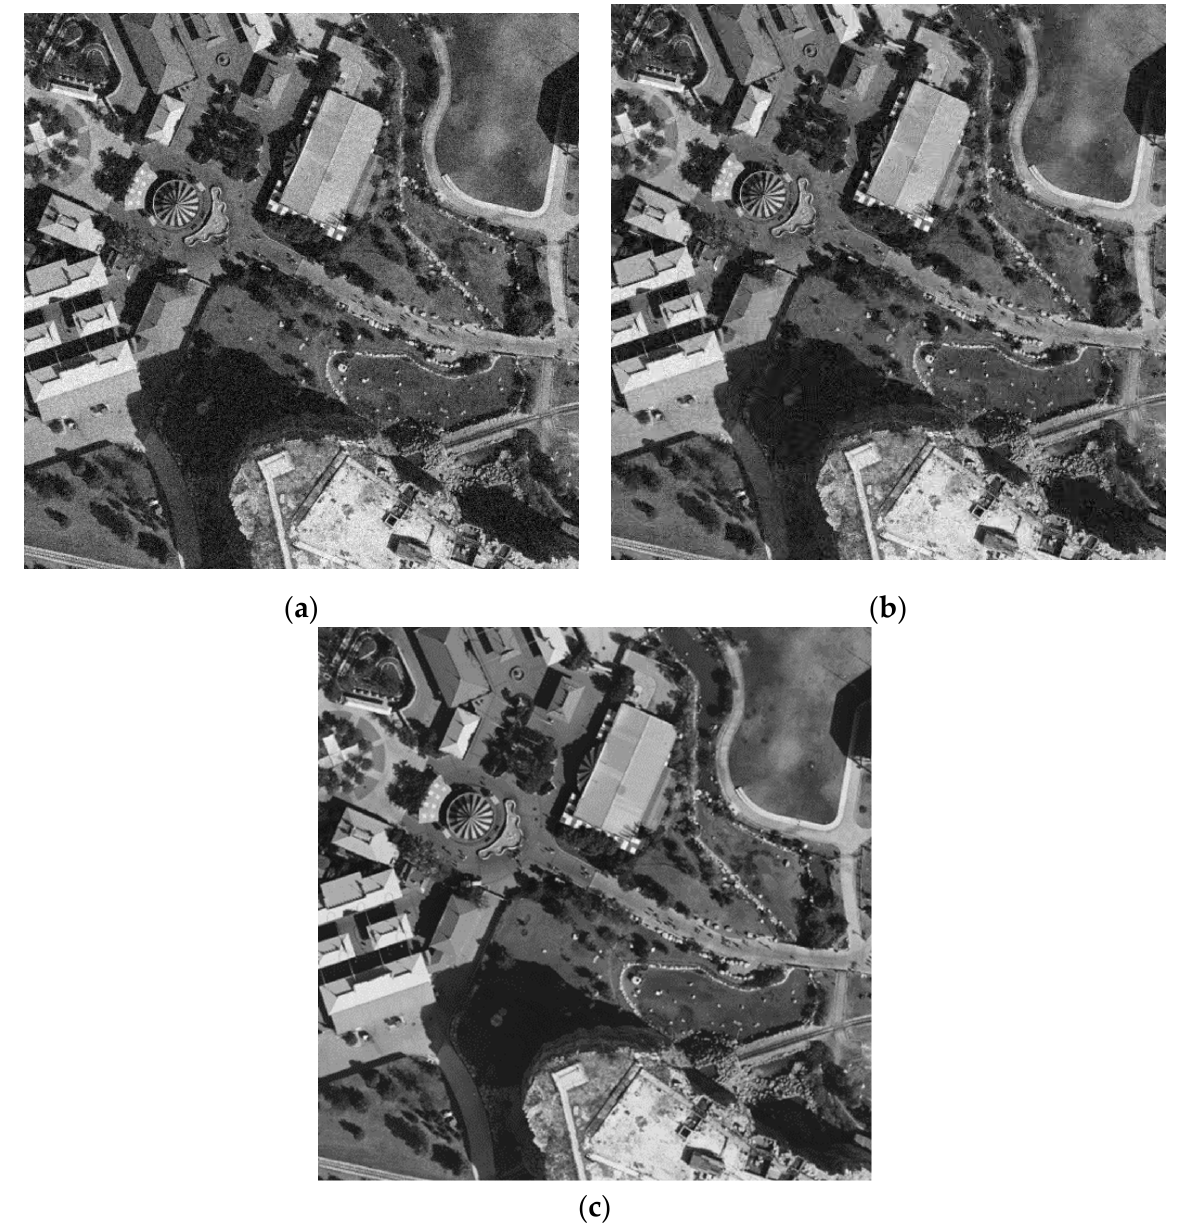
Figure 16. Noisy image Fr02 ( a ) with noise variance equal to 196 and the same image compressed using Q OOP = 37 ( b ), the noise-free image ( c ).